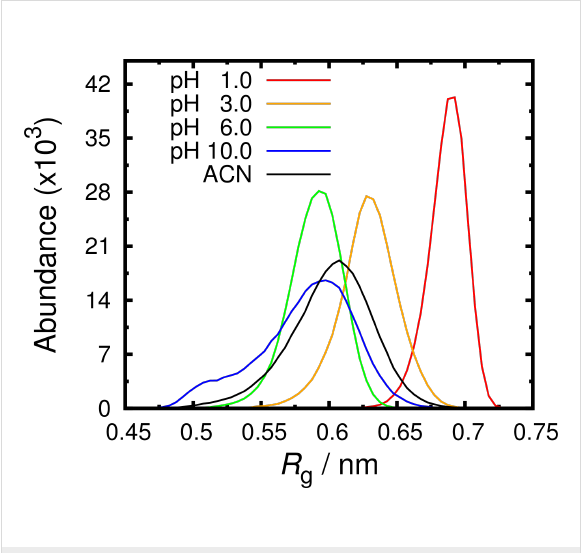
Figure 4: Radius of gyration ( R g ) histograms for the receptor in water at pH 1.0, 3.0, 6.0, 10.0 and in ACN. The R g curves at the pH values not shown are well behaved and respect the observed